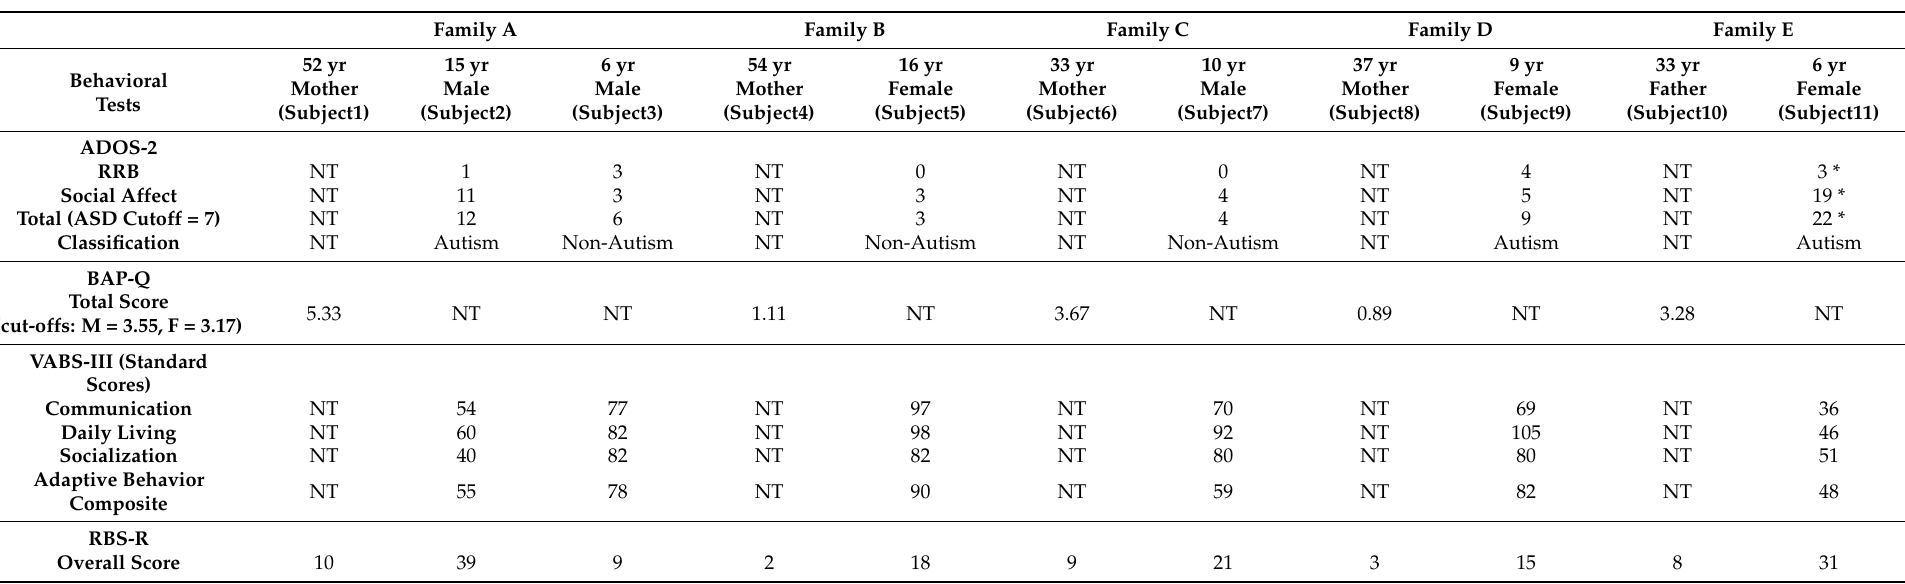
Table 2. Behavioral testing and results for families with 15q11.2 BP1-BP2 deletion syndrome. Family A Family B Family C Family D Family